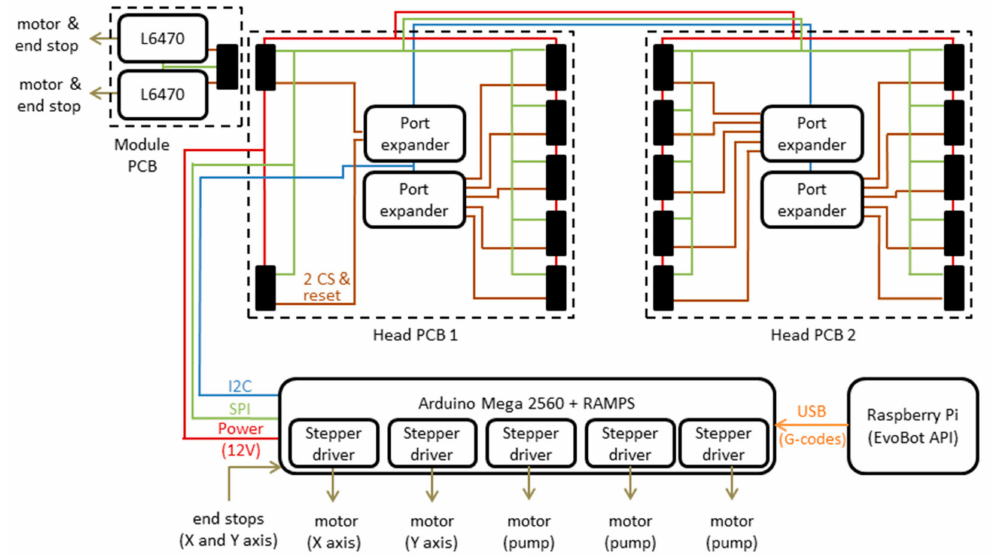
Figure 6. Main electronic components. The dotted lines represent the developed PCBs, and the black rectangles represent the connectors of the sockets and the module boards. Two of the stepper drivers on the RAMPS board are used to control the head; the other three are available to control other devices such as peristaltic pumps. To reduce the number of lines between the Arduino and the head boards, there are expander ports with I2C communications to generate the Chip Select and reset lines for all the